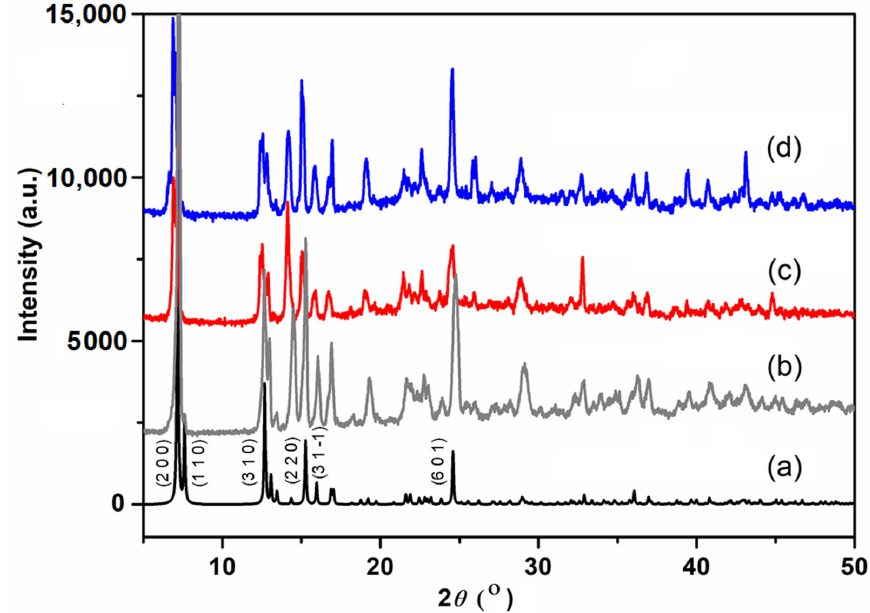
Figure 2. PXRD patterns of Cu(AZPY)-MOF . The simulated pattern from the X-ray data ( a ), the pattern for the as-prepared sample ( b ), the pattern for the sample after 1 day in H 2 O ( c ) and the pattern for the sample after 1 day in PBS ( d ).